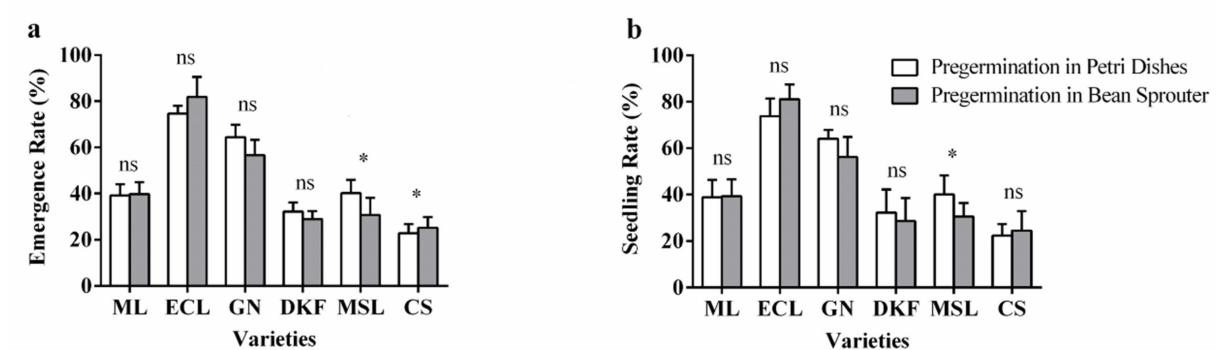
Figure 8. Effect of pre-germination treatments on seed seedling characteristics of tested varieties: ( a ) influence of pre-germination treatments on seed emergence rate of tested varieties, and ( b ) in- fluence of pre-germination treatments on seed seedling rate of tested varieties. Data in this figure were tested by Student’s t test; * p < 0.05 represent significant differences between treatments, and ns indicates not significant. ML, ECL, GN, DKF, MSL, and CS represent varieties of Meili, Ecolly, Garanior, Dunkelfelder, Marselan, and Cabernet